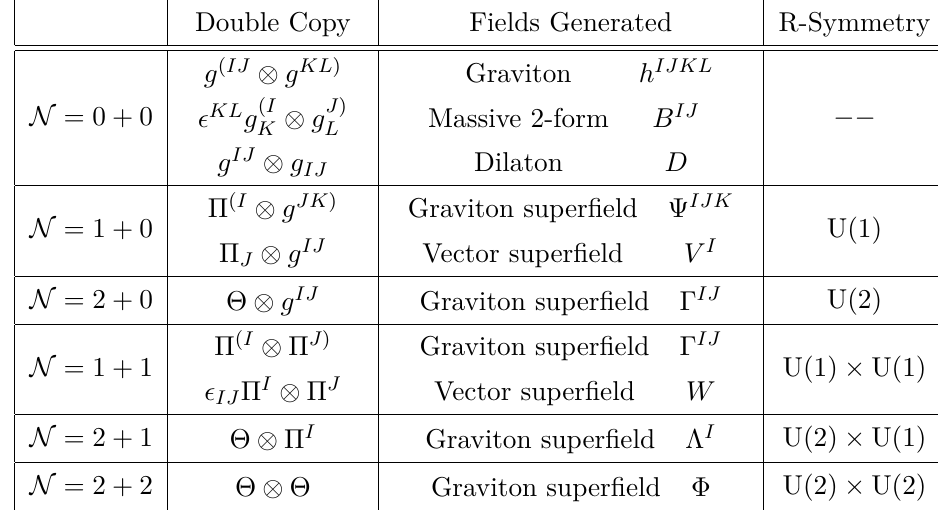
Table 5. To realize supermultiplets with different numbers of supersymmetries N as double copies, we use the double copy prescriptions listed in the table above. In both cases where a vector superfield is generated, the N = 1 and N = 2 vector multiplets V I and W , these contain both the dilaton and 2-form fields. Here g IJ , Π I and Θ are the N = 0 , N = 1 and N = 2 massive gluon multiplets given in section 5.1. Note that there are two ways to realize an N = 2 graviton supermultiplet as a double